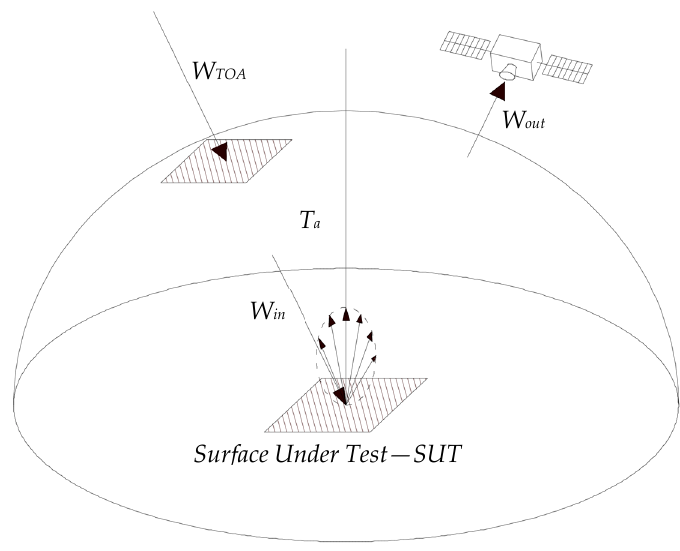
Figure 3. Parameters used to determine the RF of a SUT .